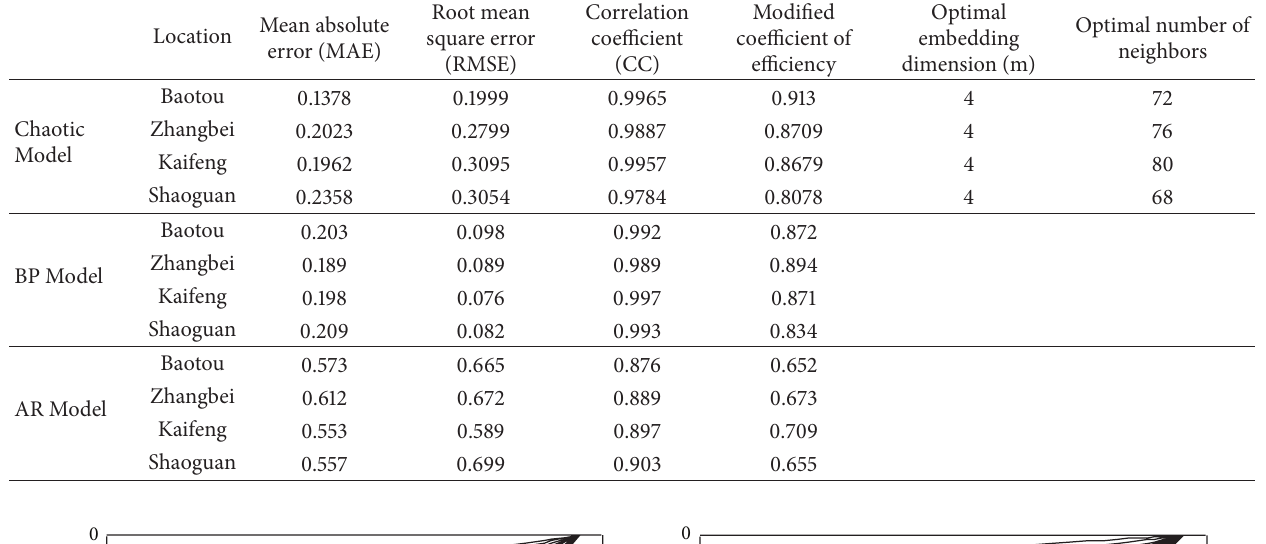
Table 4: Prediction results for daily reference evapotranspiration of the stations selected in China by chaotic model, AR model, and BP neural network model.